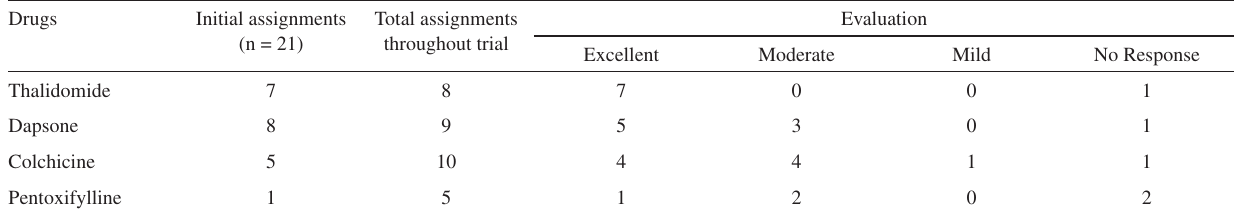
Table 4 - Efficacy of the drugs prescribed in the trial Drugs Initial assignments (n = 21)